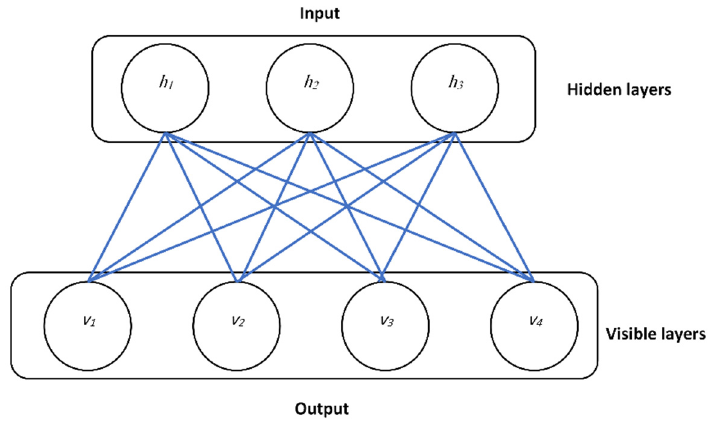
Figure 1. RBM Structure